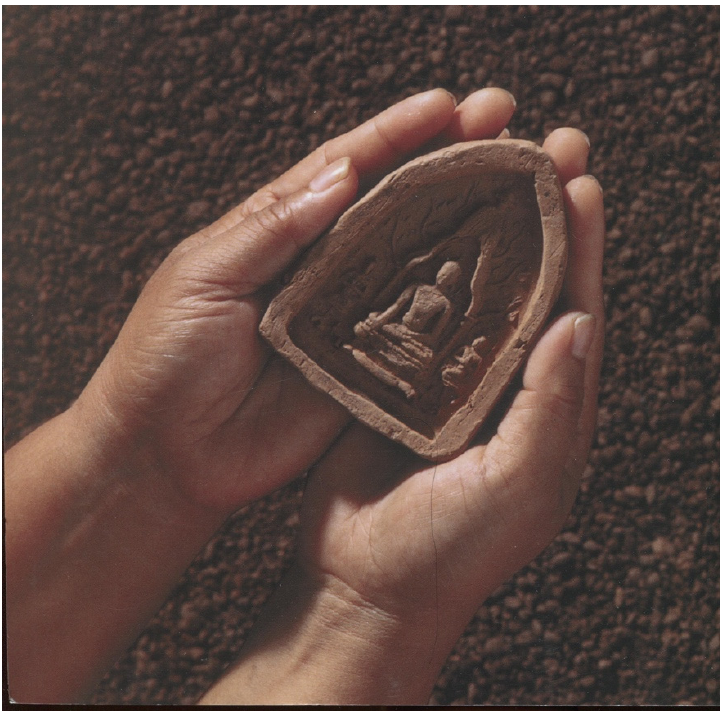
Figure 20. Clay Buddha, Pagan period, 12th–13th centuries, 9.6 × 7.1 cm, Myanmar [Source: (Fukuoka Art Museum 2008, cover picture)].